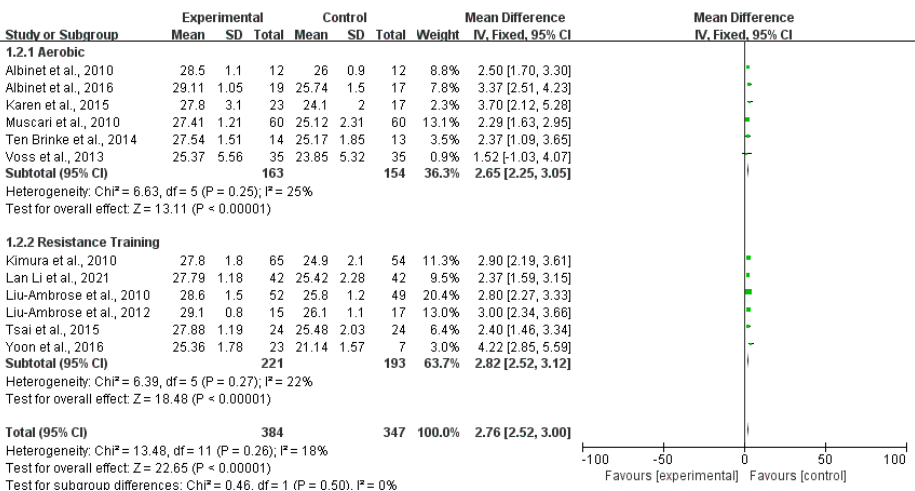
Figure 3. Forest plots of MMSE scale outcomes in overall analysis [10,11,13,17,20,21,25–30].